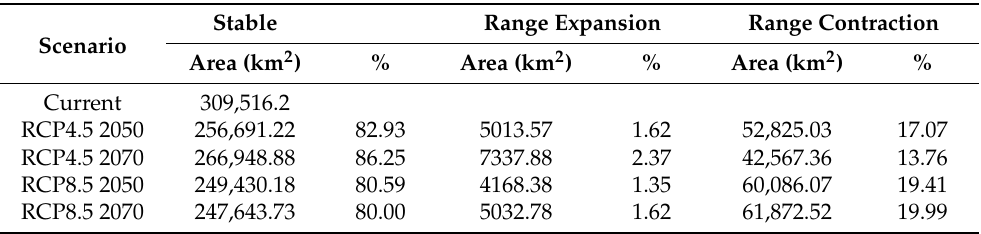
Table 3. Estimated range change for Garuga forrestii under RCP4.5 and RCP8.5 for 2050 and